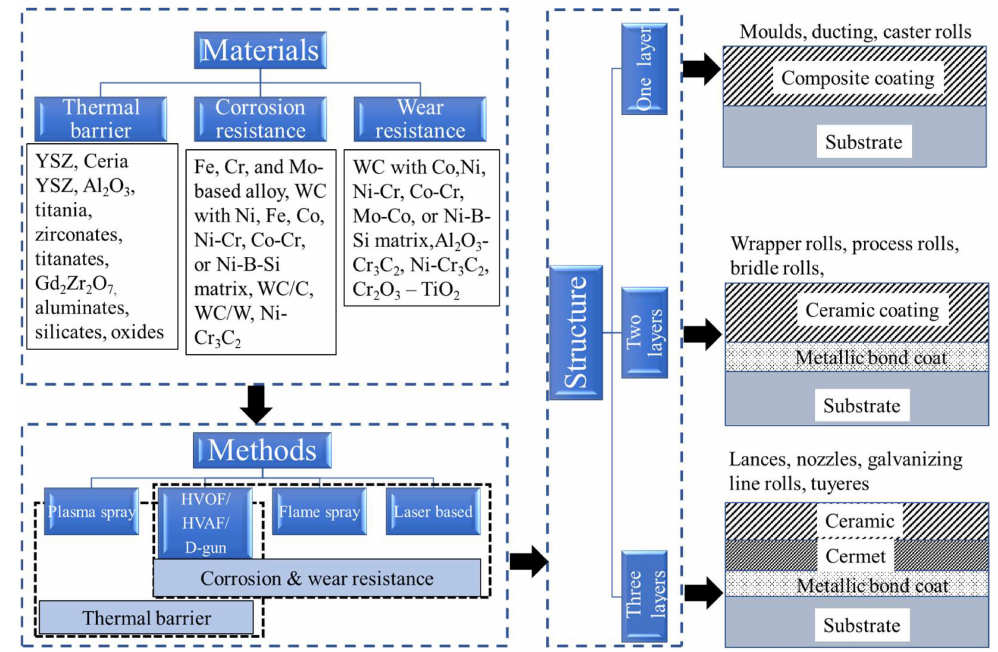
Figure 18. A schematic representing the materials, methods and structure of the coatings that are being applied in iron and steel making